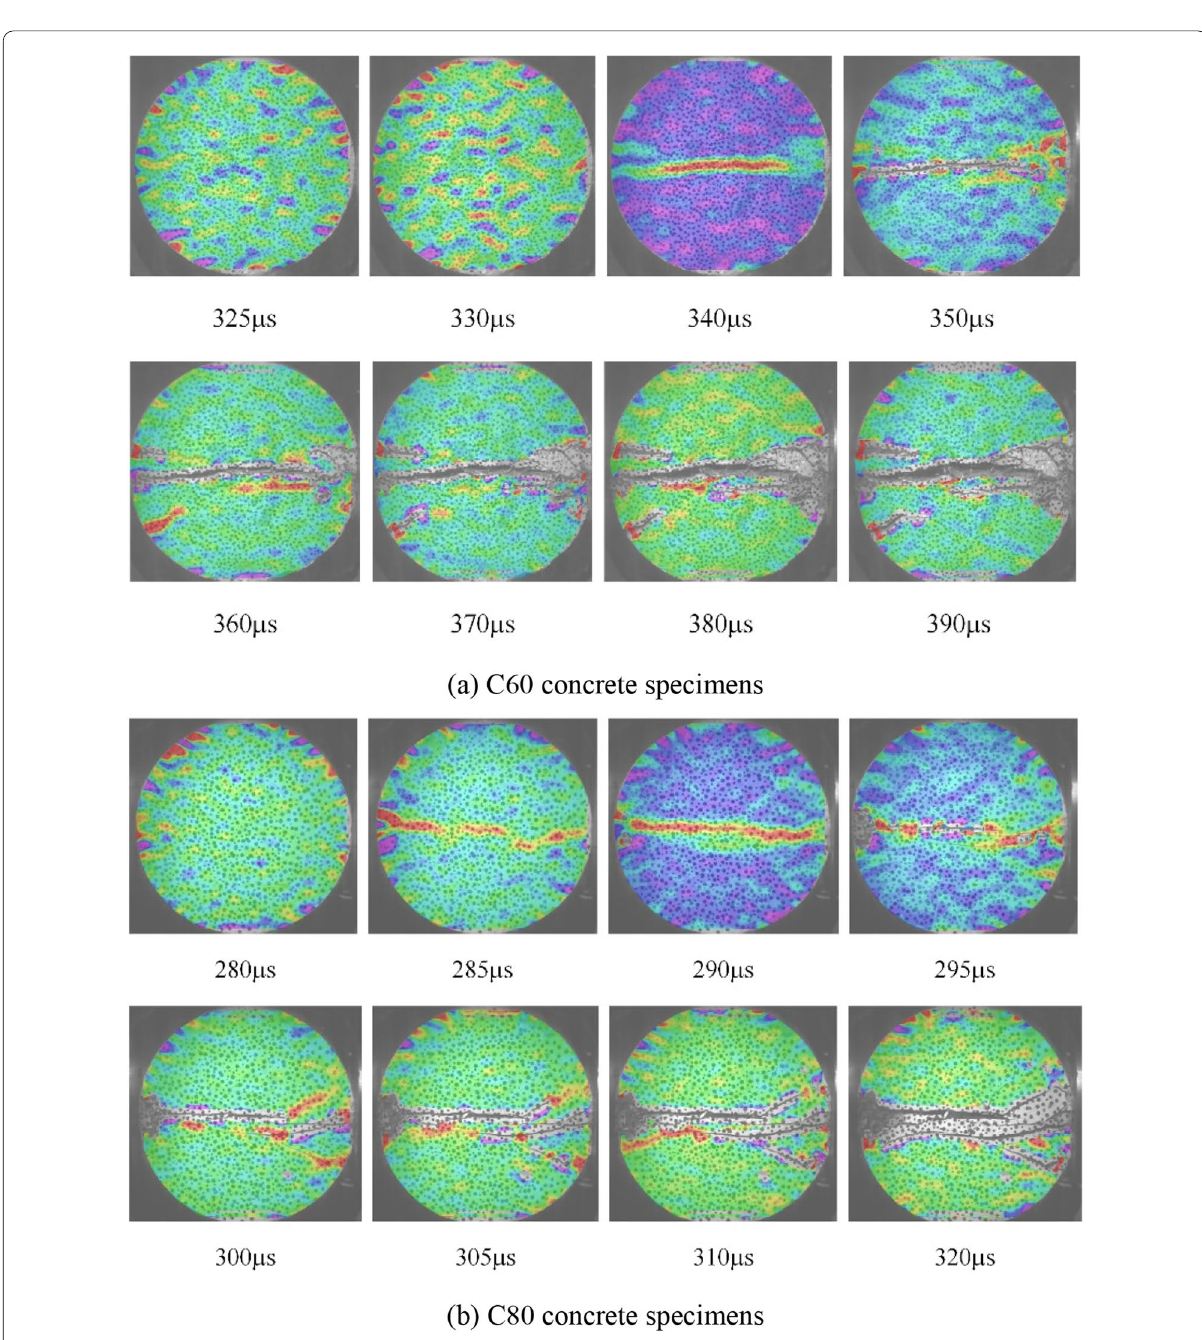
Fig. 13 Strain cloud of high-strength concrete under 0.09 MPa impact